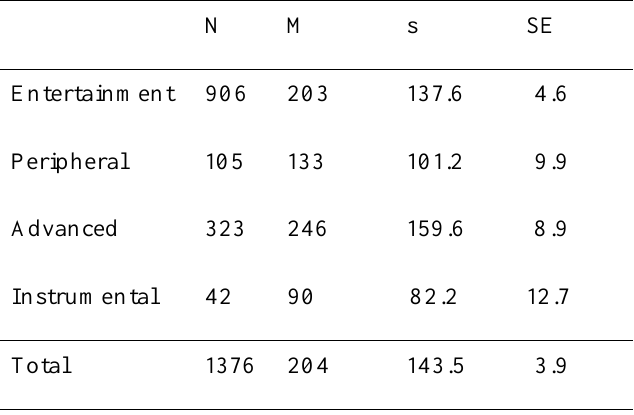
Mean Number of Friends in Social Networks